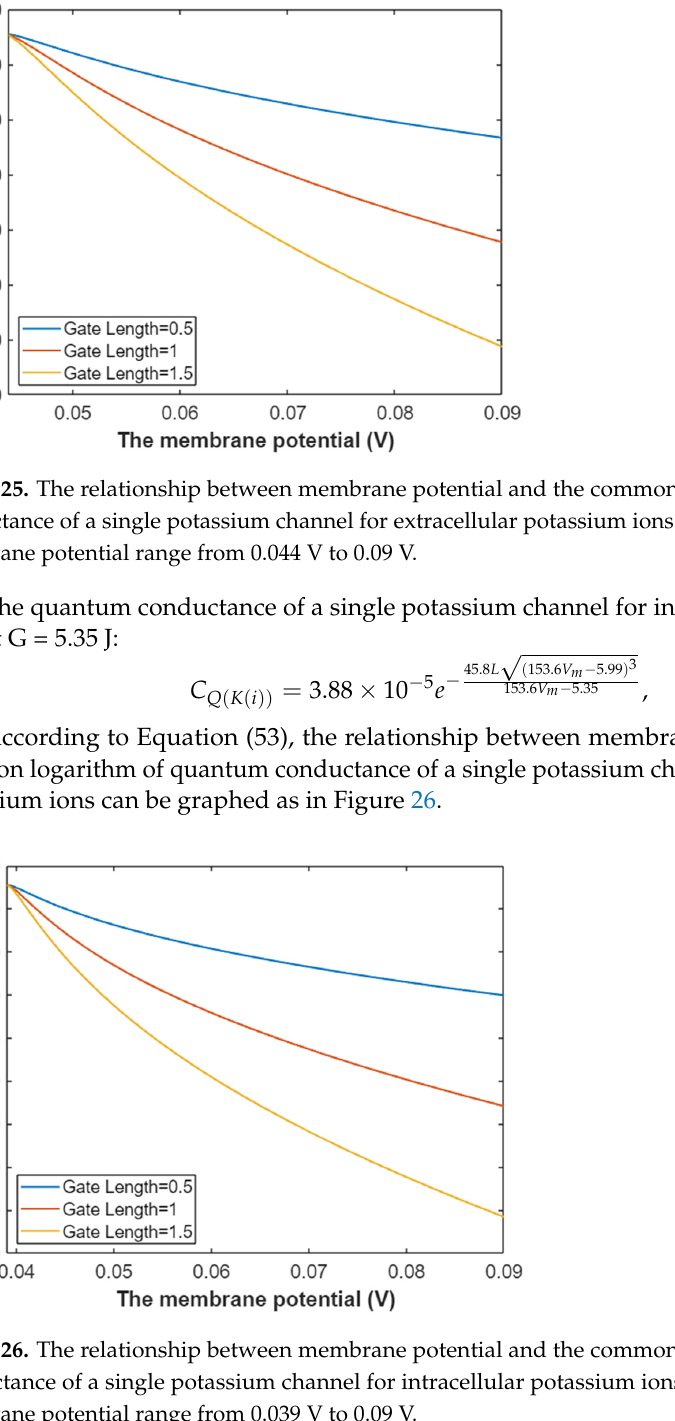
Figure 24. The relationship between gating free energy and the common logarithm of tunneling probability of intracellular potassium ions at membrane potential of 0.087 V and over a gating free energy range from 5 J to 12.72 J.